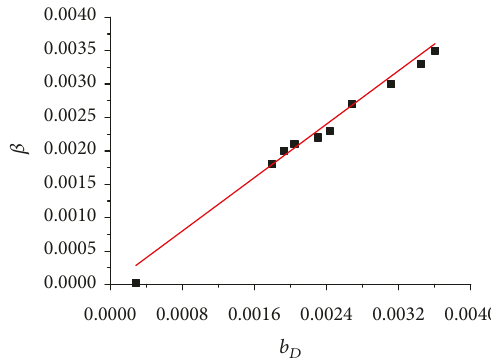
β of fracture samples F1 – D and